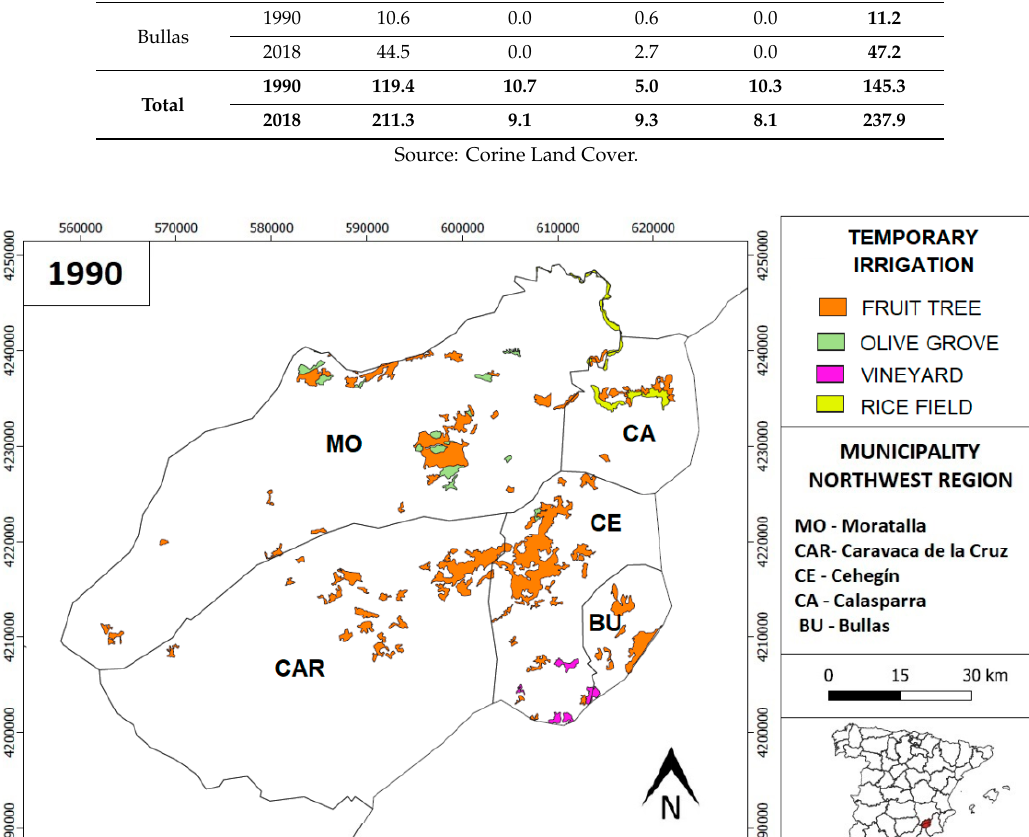
Figure 14. Spatial distribution of temporary irrigation crops (2018). Source: Authors.